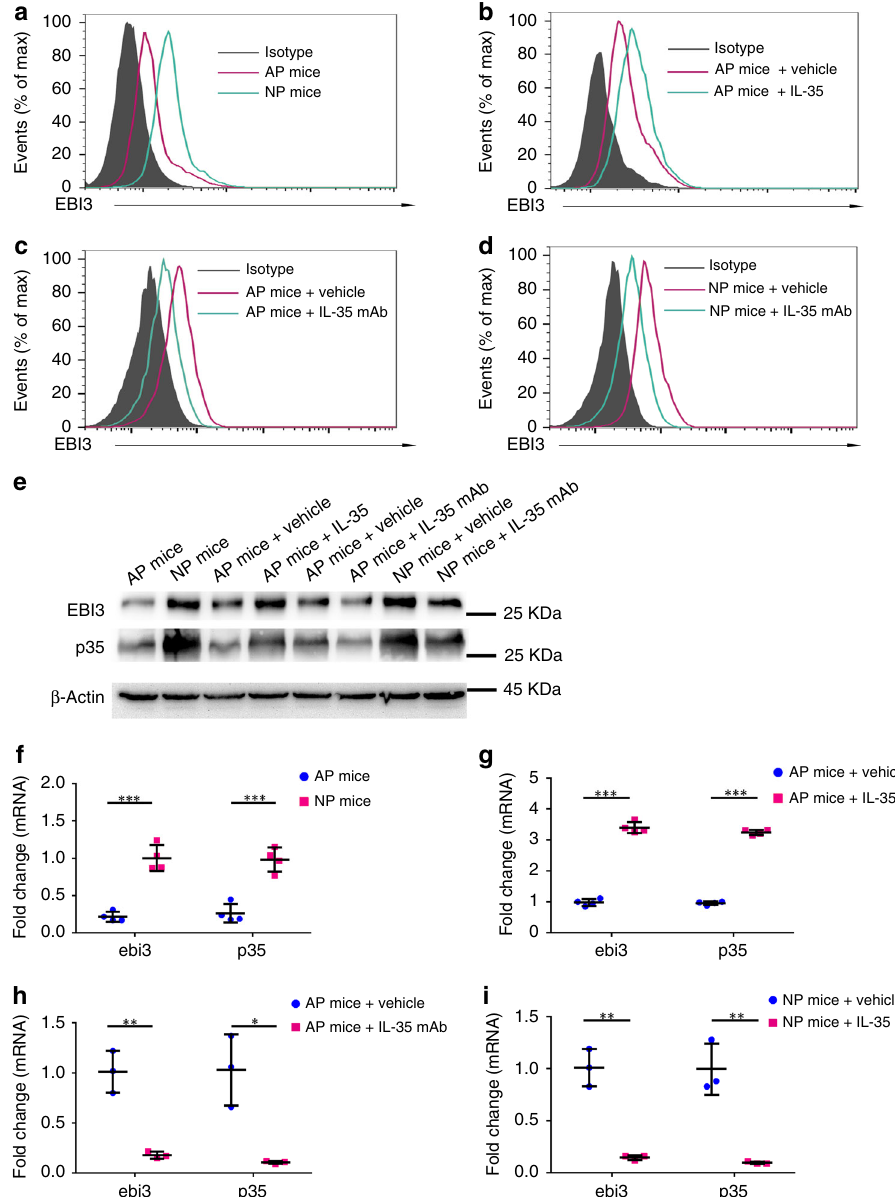
Fig. 6 IL-35 expression pattern in T conv cells from different treated NP or AP mice. Pregnant CBA/J female mice were euthanized on Day 13.5 of pregnancy, the decidua was isolated and teased apart. a – d T conv cells were isolated from the decidua and stained with anti-EBI3 or isotype-matched control antibody (Isotype) for fl ow cytometry analysis. e The protein levels of EBI3 and p35 in T conv cells were determined by western blot. f – i The mRNA level of ebi3 and p35 in decidual T conv cells were analyzed using quantitative real-time RT-PCR analysis. The results were normalized to endogenous control ( 4 for AP mice group, n = 4 for NP mice group. g n = 4 for AP mice + vehicle group, n = 4 for AP mice + IL-35 group. h n = 3 for AP mice + vehicle group, n = 3 for AP mice + IL-35 mAb group. i n = 3 for NP mice + vehicle group, n = 3 for NP mice + IL-35 mAb group. Data were represented as mean ± SD. Signi fi cance was determined by Student ’ s t -test. * P < 0.05, ** P < 0.01, and *** P < Isolation and culture of human peripheral T conv cells . Human peripheral blood mononuclear cells (PBMCs) were isolated by density gradient centrifugation using